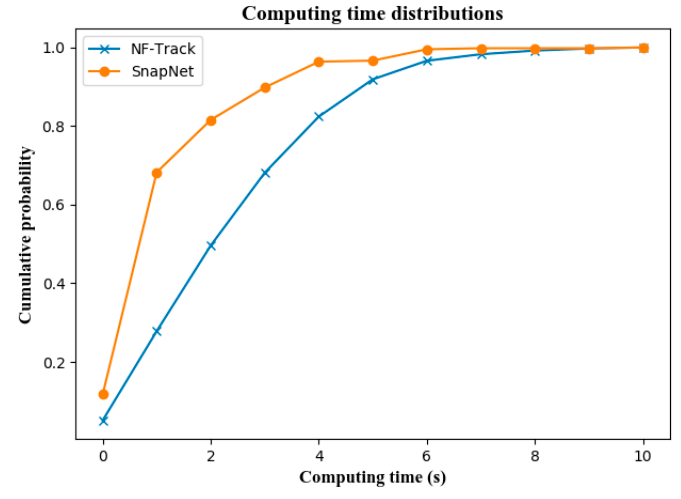
Figure 23. The computing latency per trajectory update.